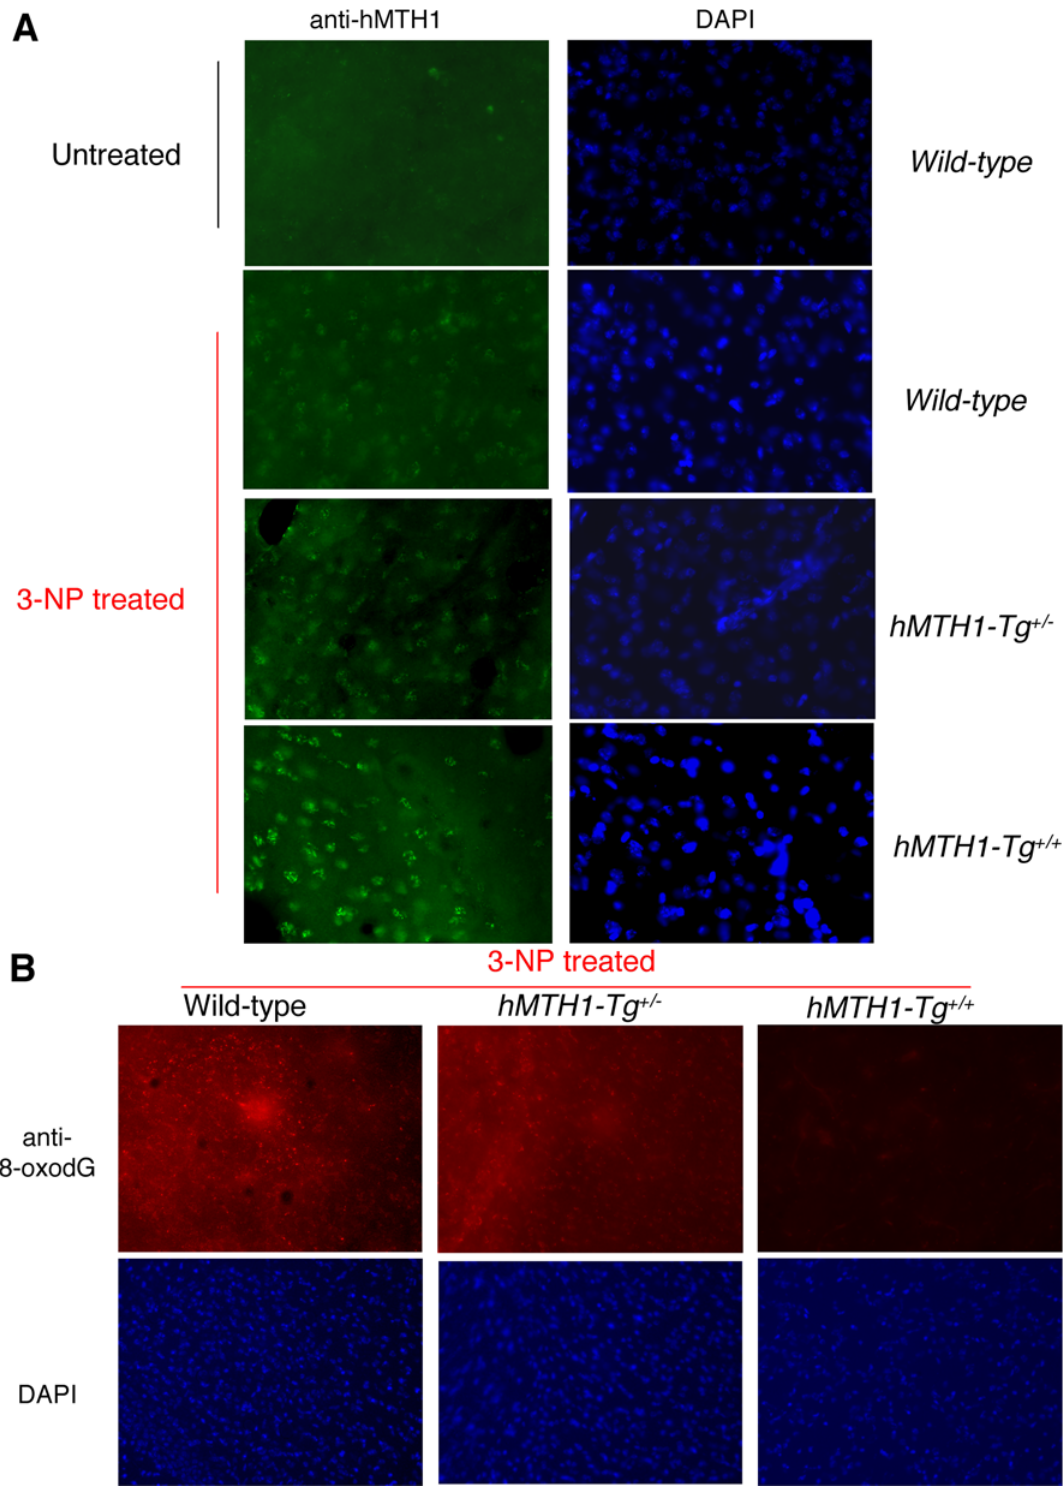
Figure 7. MTH1 expression and 3-NP-induced oxidative DNA damage in the brain. (A) Immunofluorescence of MTH1 in the striatum of untreated wild-type mice (top panel, left) or 3-NP-treated (60 mg/kg twice daily for 5 days) wild-type, hMTH1-Tg + / 2 , and hMTH1-Tg + / + animals. Nuclei of striatum counterstained by DAPI are shown in the right panels. (B) 8-oxodG immunoreactivity in the striatum of 3-NP-treated wild-type, hMTH1- Tg + / 2 , and hMTH1-Tg + / + animals. Nuclei of striatum counterstained by DAPI are shown in the bottom panels.